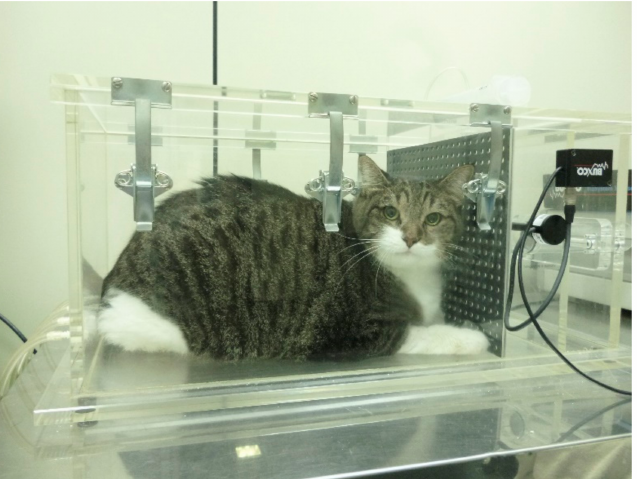
Figure 1. Obese cat placed in the barometric whole-body plethysmography chamber. The cat seems to be very comfortable during testing as the procedure is of limited or no stress to the